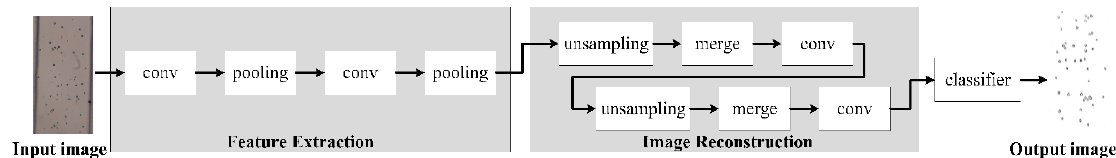
Figure 6. Cell Division Network (CSnet) structure.